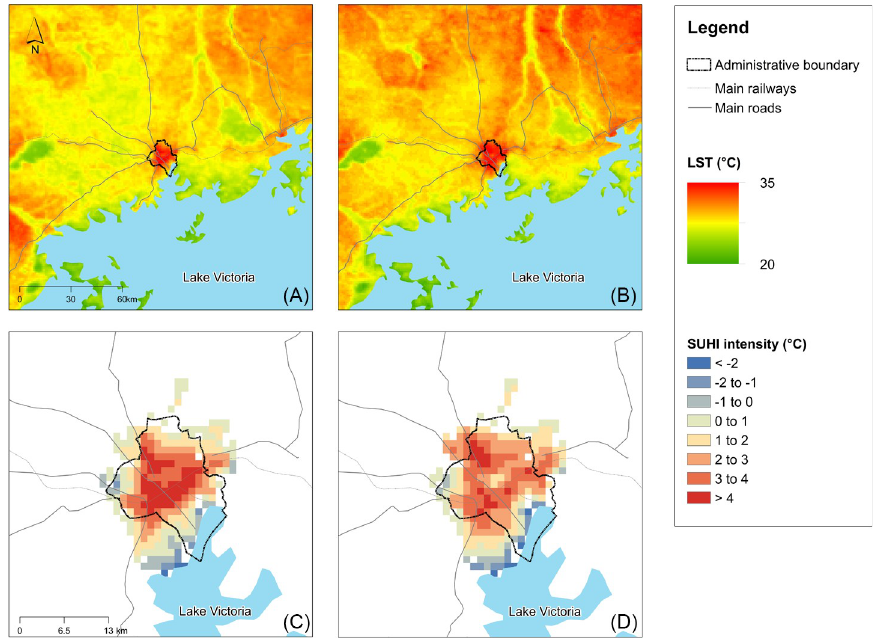
Fig 3. Average annual daytime temperature in 2003 (A) and 2017 (B) for Kampala and the surrounding region. Annual daytime SUHI intensity of Kampala in 2003 (C) and 2017